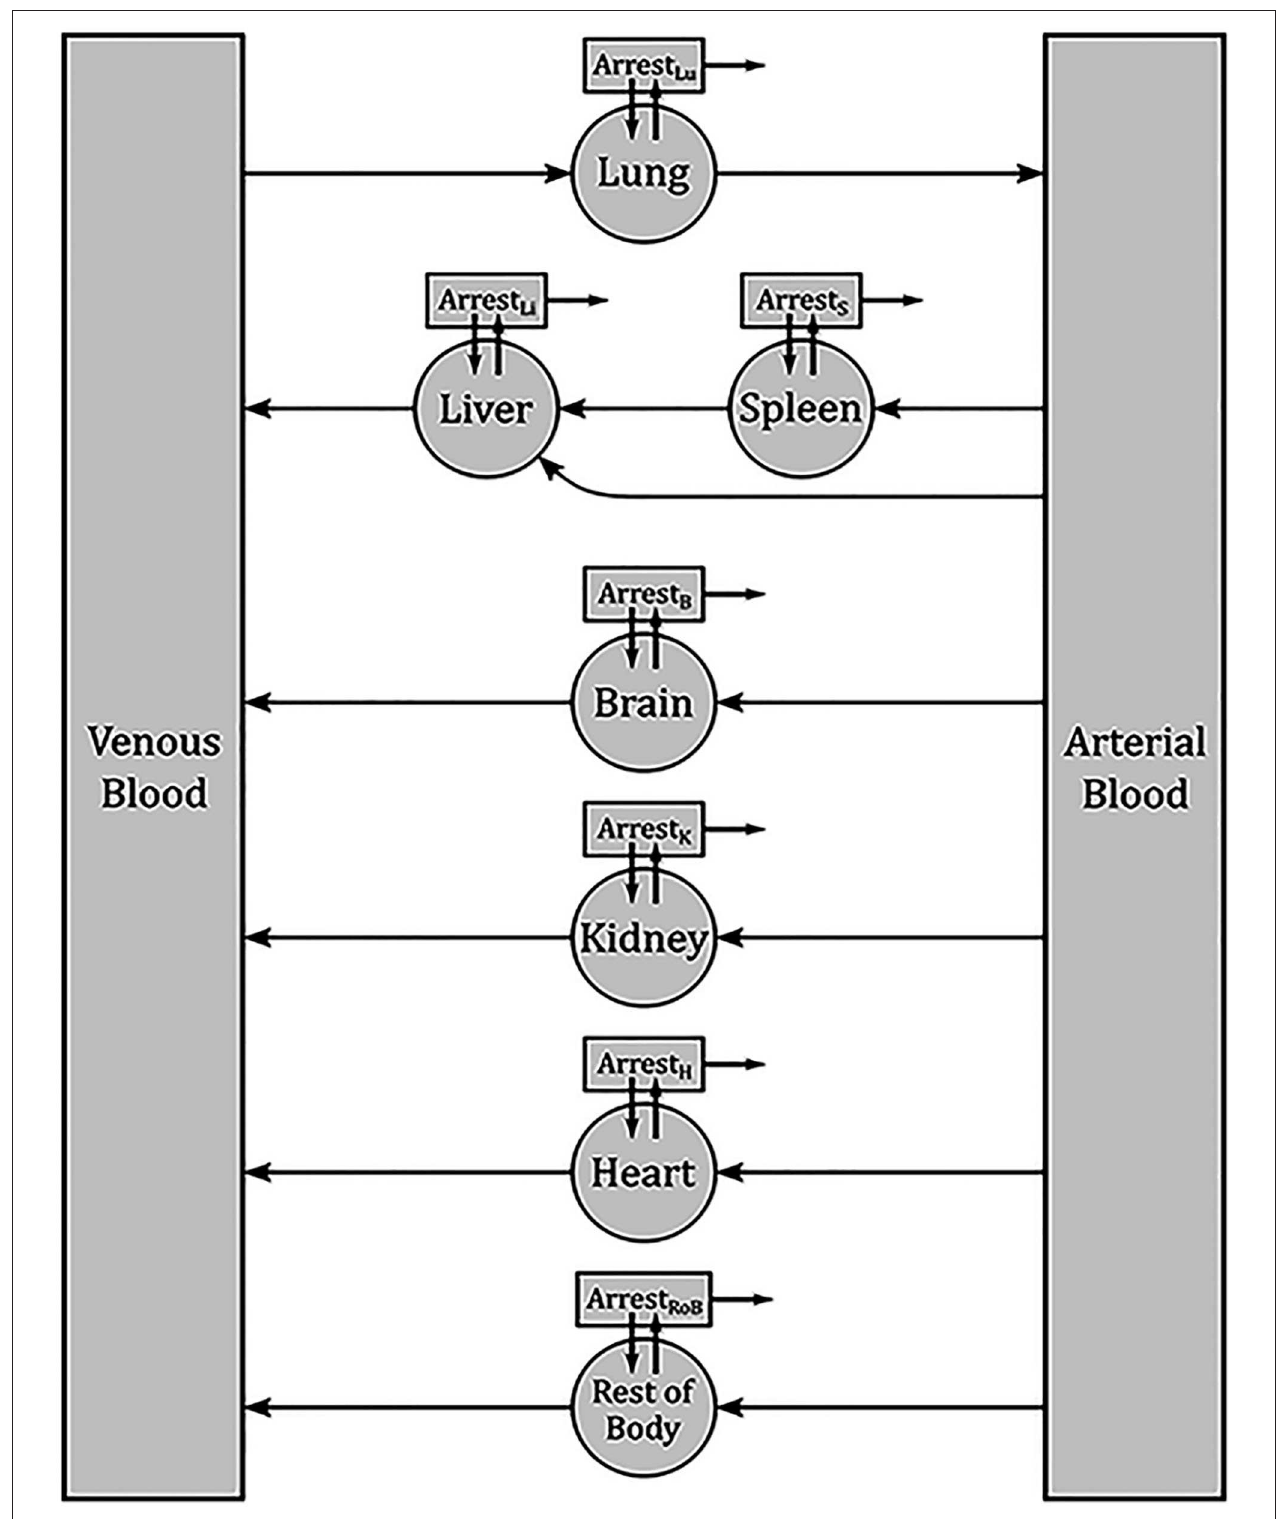
FIGURE 2 | Sketch of the PBPK model for the biodistribution of MSCs in rabbits. Each box denotes one compartment and each arrow one pathway. Each transition rate is described by one kinetic constant. The main compartments for each organ describe the respective interior blood vessels. From there, MSCs can be released back into blood or arrested. Arrested cell can return into the organ blood vessels or be